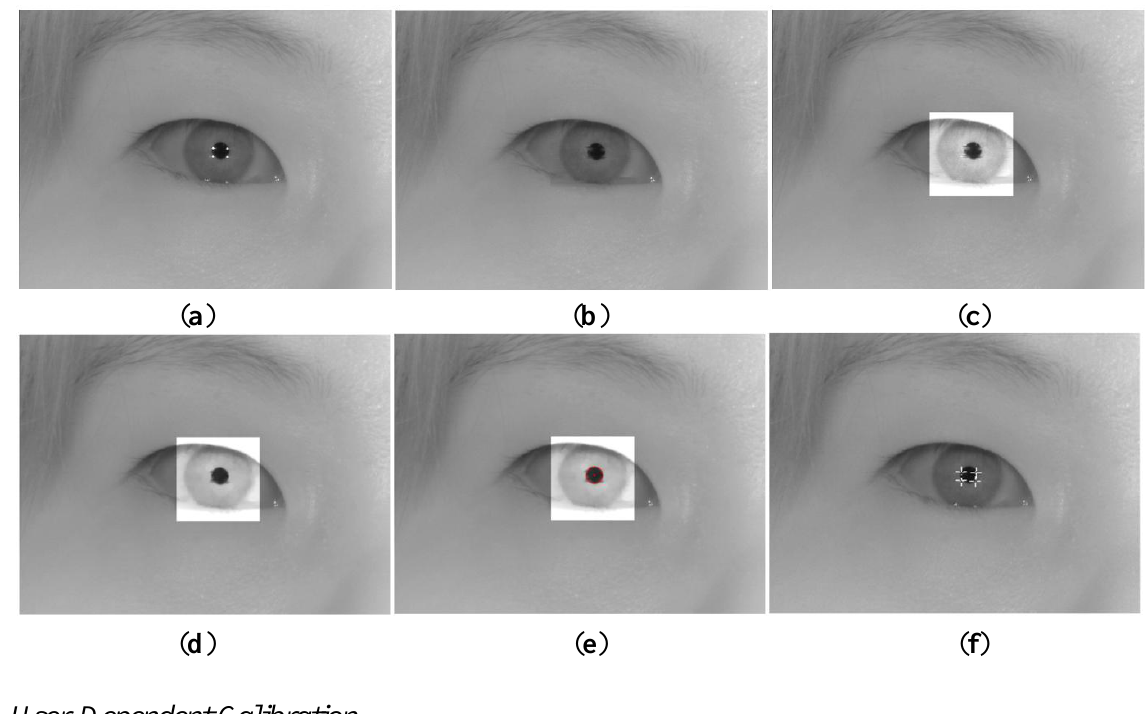
Figure 10. Steps for obtaining pupil center and four SR centers. ( a ) Original image. ( b ) Results of removing SRs. ( c ) Results of histogram stretching. ( d ) Results of the morphological operation. ( e ) Detection results of the pupil using CED. ( f ) Detection results of four